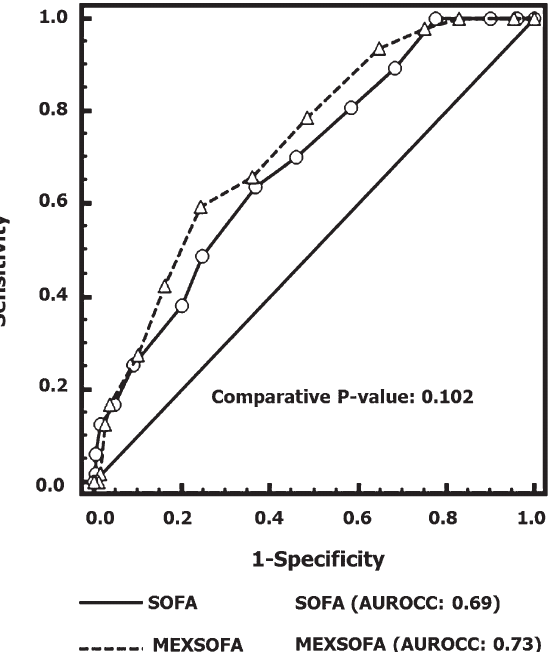
Figure 2. Comparisons of the areas under the receiver operating characteristic curves (AUROCC) for the prediction of mortality of the initial sequential organ failure assessment (SOFA) score and the Mexican sequential organ failure assessment (MEXSOFA). There was no difference between the initial SOFA [AUROCC = 0.69 (95%CI = 0.62-0.74)] and the initial MEXSOFA [AUROCC = 0.73 (95%CI = 0.66-0.78)] scores.